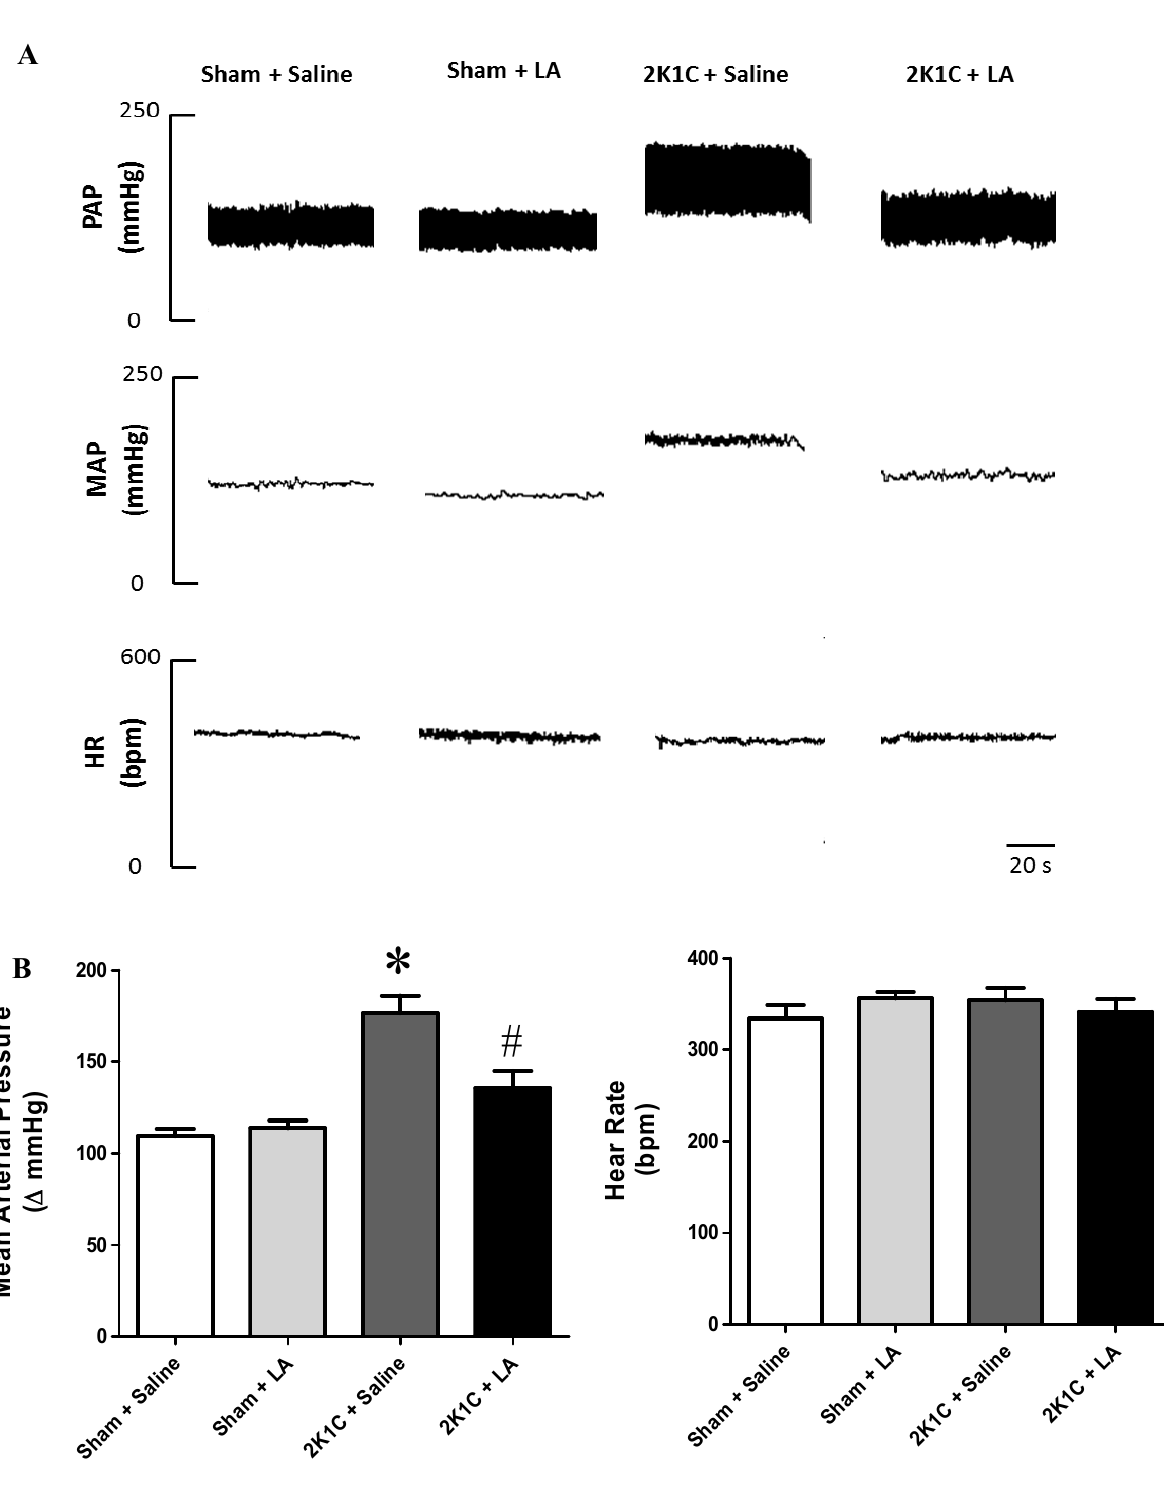
Figure 2. ( A ) Representative tracings showing the changes in pulse arterial pressure (PAP, mmHg), mean arterial pressure (MAP, mmHg), and heart rate (HR, bpm) of a rat from Sham + Saline; Sham + LA; 2K1C + Saline and 2K1C + LA groups four weeks after clipping the right renal artery. ( B ) MAP and HR values of Sham + Saline (n = 6, open bar); Sham + LA (n = 6, light grey bar); 2K1C + Saline (n = 6, dark grey bar) and 2K1C + LA (n = 6, black bar) groups. * p < 0.05, when compared to Sham + Saline group. # p < 0.05, when compared to 2K1C + Saline